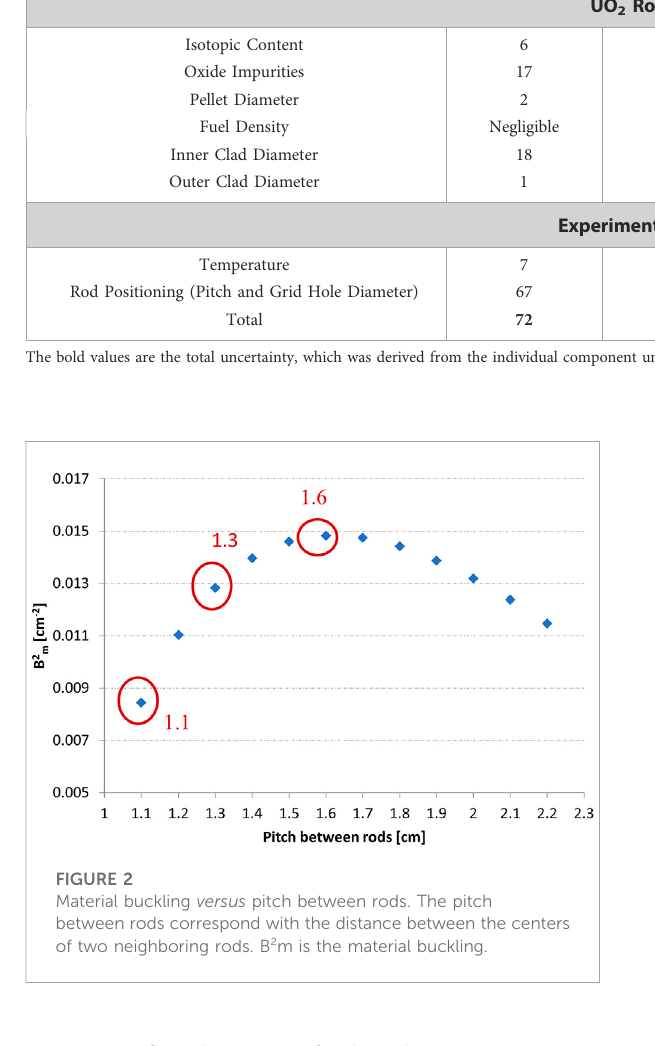
TABLE 3 Array dimension versus moderation